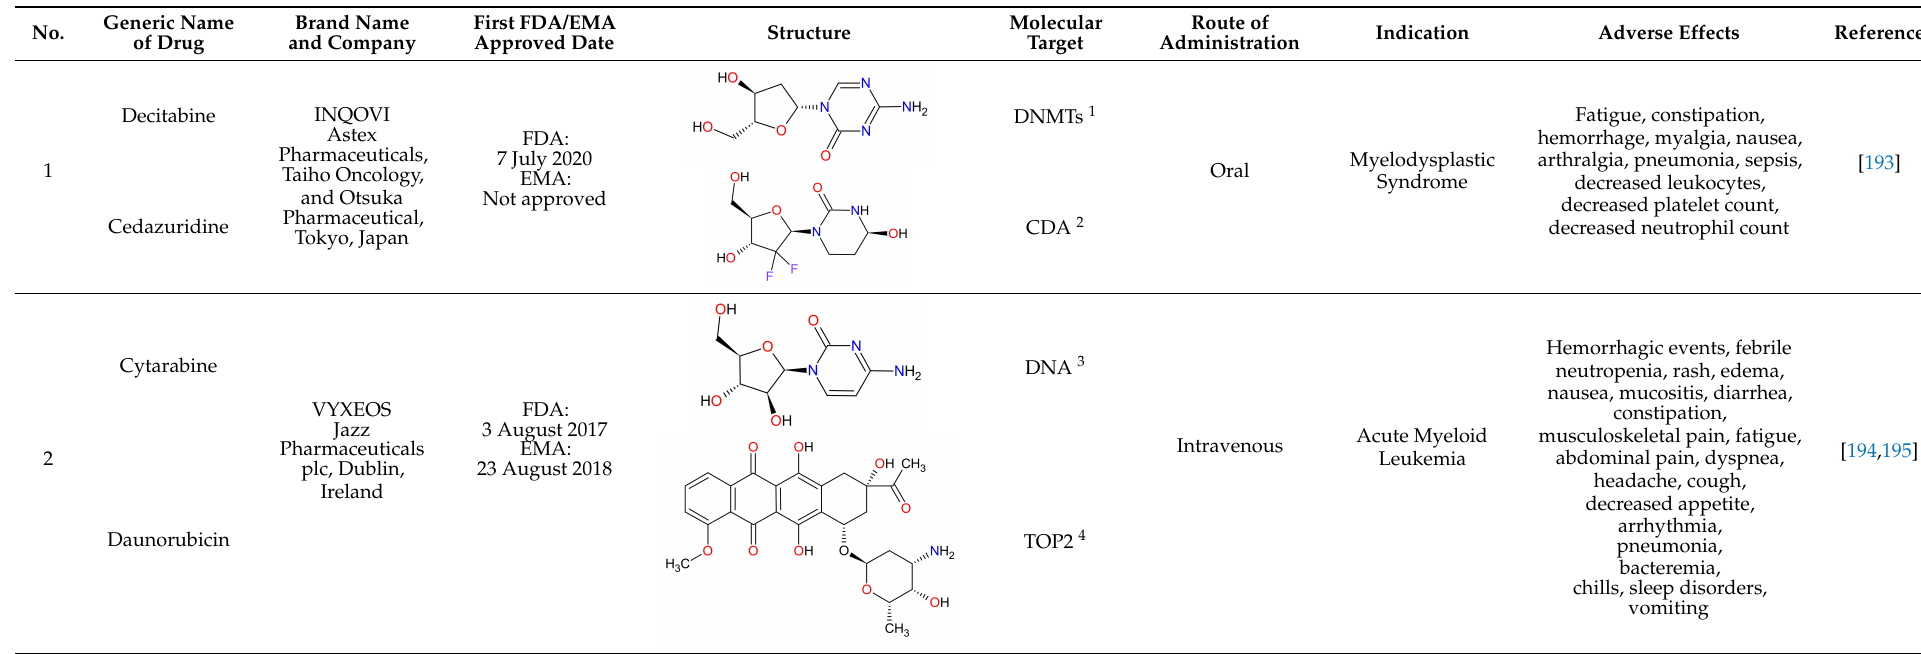
Table 10. Features of the dual-drugs approved by the Food and Drug Administration (FDA) from 2011 to 2021. The order of drugs is tabulated in order of most recent to oldest registration